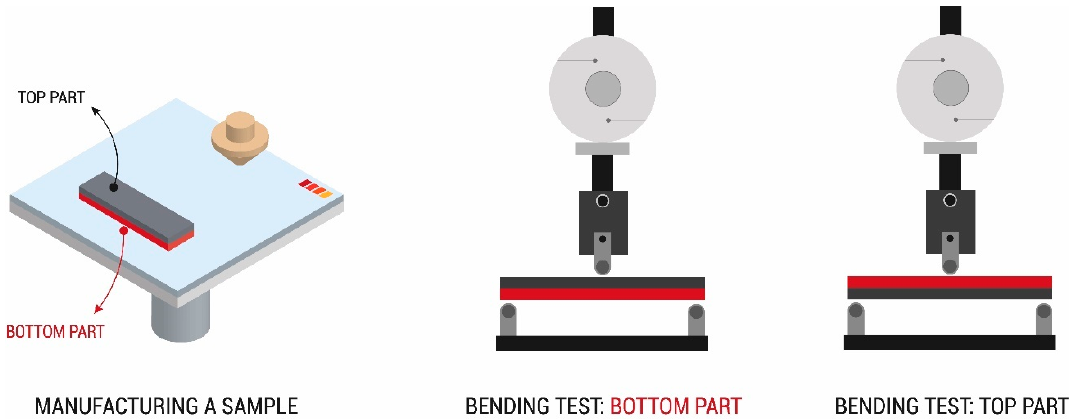
Figure 4. Positioning samples in the bending test, labelled (top and bottom) according to printing placement.